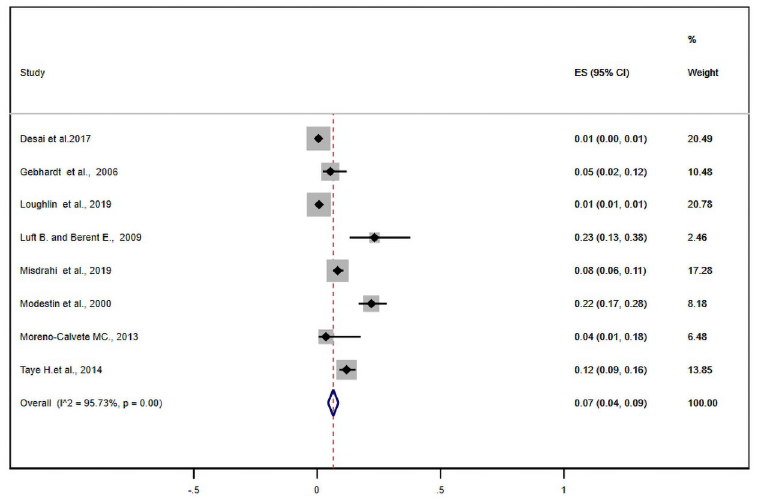
Fig 6. Forest plot depicting anti-psychotic induced tardive dyskinesia.